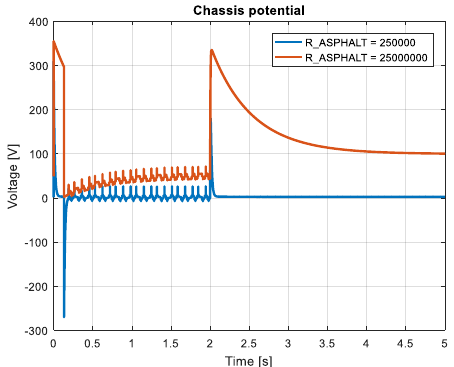
Figure 4. Chassis potential under negative rail connection loss.